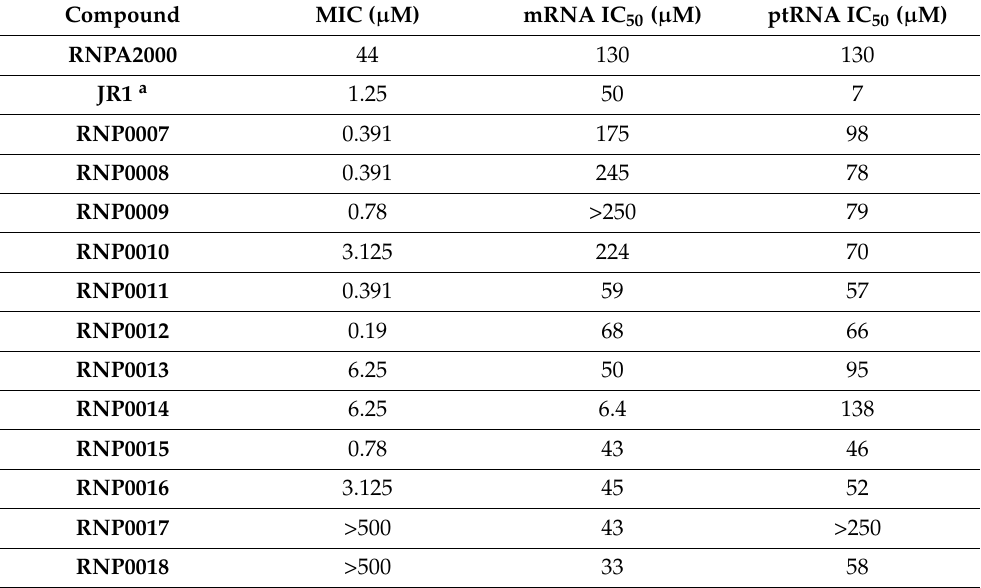
Table 2. MIC and in vitro inhibition values for RNA